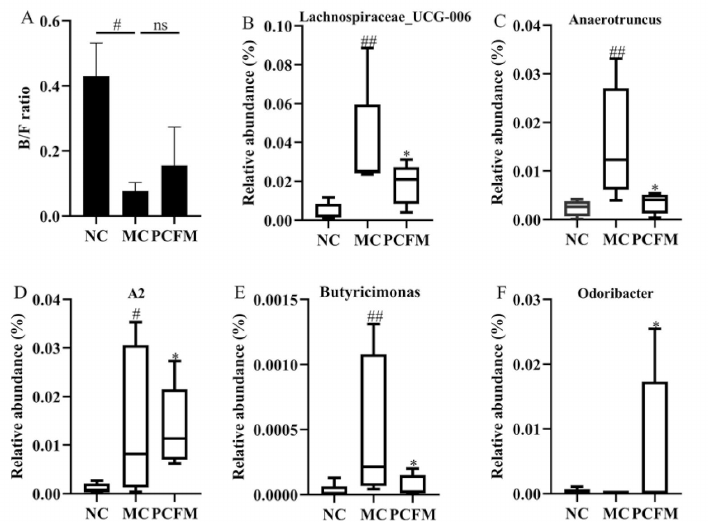
Figure3. After5weeks’treatment, e ff ectofprolaminfromcookedfoxtailmillet(PCFM)supplementation on the Bacteroides / Firmicutes (B / F) ratio ( A ) and the relative abundance of bacteria at the genus level ( B – F ) in all groups ( n = 7 mice / group). The B / F ratio between two groups was analyzed by Student’s t test. Relative abundance of each bacterium referred to the percent of a specific bacterium abundance in comparison to the sum of all bacteria abundance at the same classification level. Wilcoxon rank sum test was used to compare the significance of relative abundance di ff erences among all